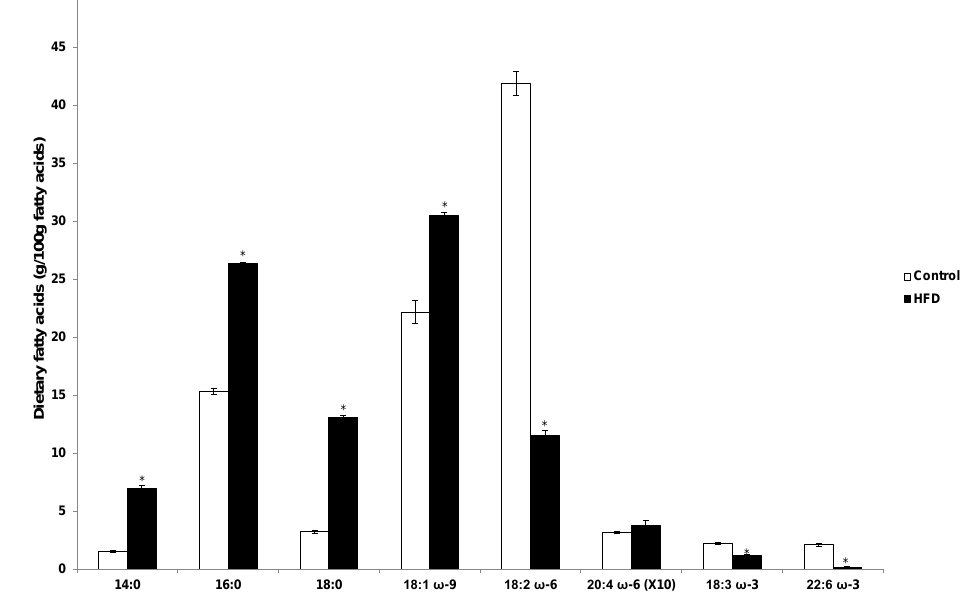
Figure 1. Dietary fatty acids (g/100 g fatty acids). Values are means ± standard error of the mean (SEM). HFD, high fat diet. * p < 0.0001.